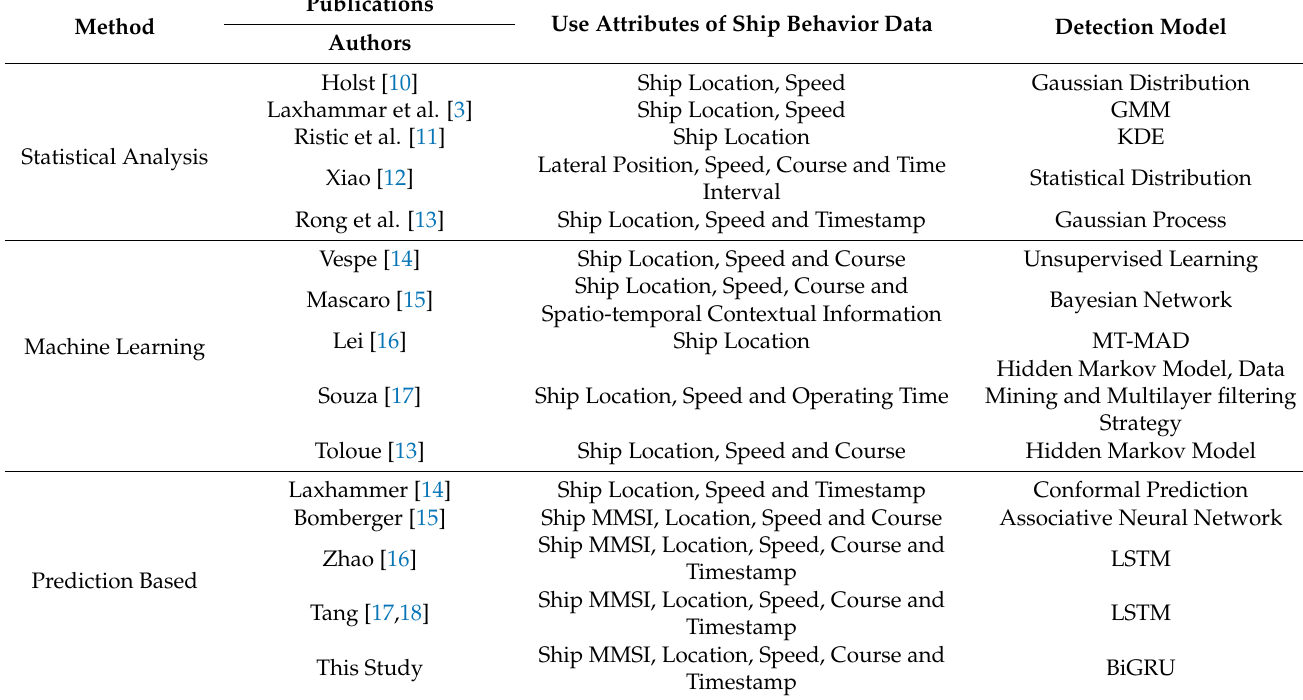
Table 1. Major features of preceding